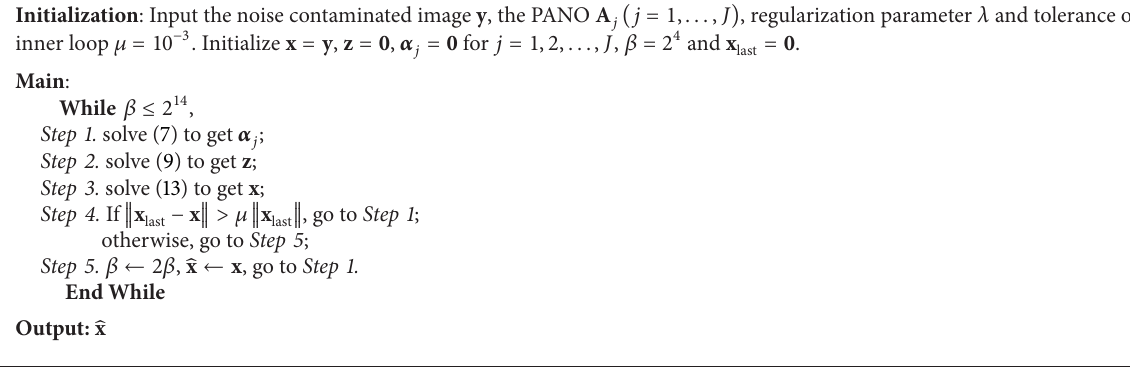
Algorithm 1: PANO-based salt and pepper noise removal with noise